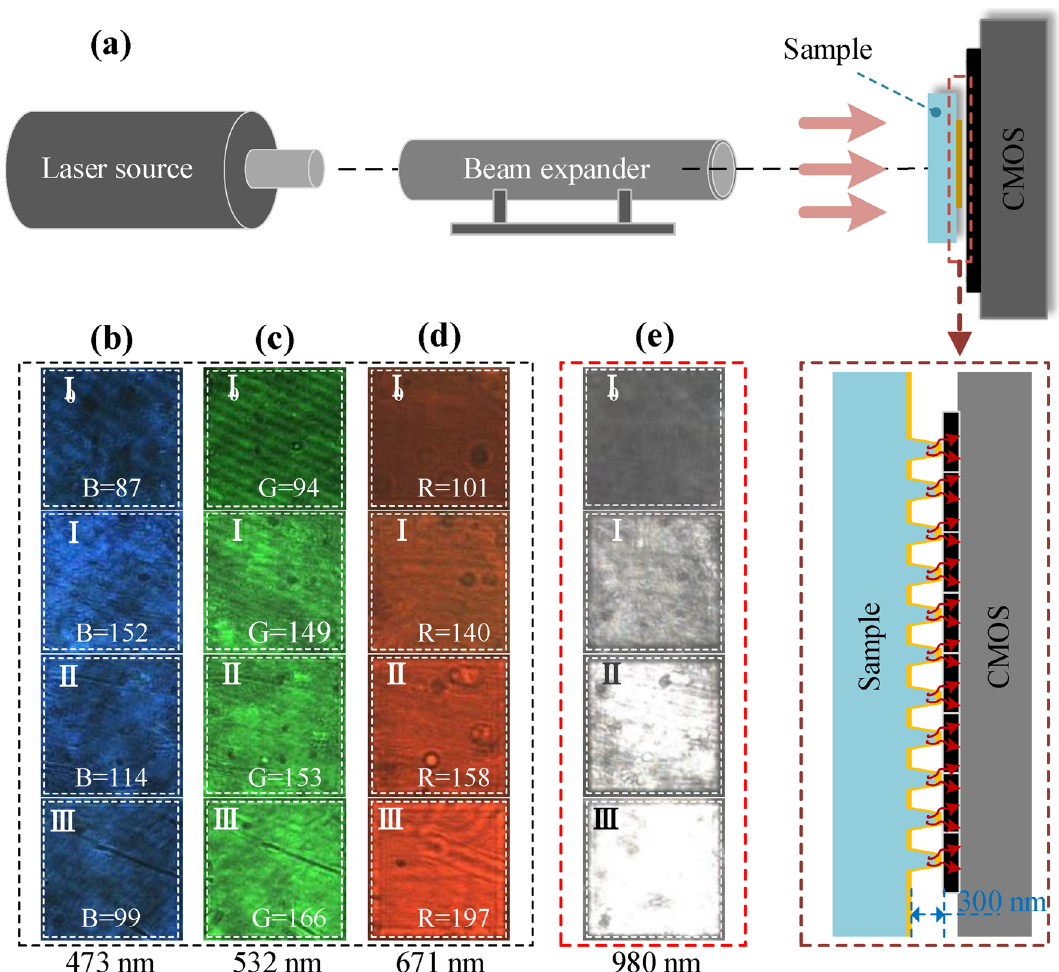
Figure 7. Detection of incident lightwaves at different wavelengths by CMOS sensors already coupled with three types of GGNCTs developed. ( a ) The coupling schematic diagram of the GGNCTs and an arrayed CMOS sensor. ( b ) to ( e ) The typical images detected at different light wavelengths including 473 nm, 532 nm, 671 nm, and 980 nm. The labels of I 0 and I to III indicate the images detected by the detector coupled to the different functional structures including the unstructured sample, the functional GGNCT-I, the GGNCT-II, and the GGNCT-III. The graphic brightness represents the strength of the imaging signal. To quantify the brightness, the pixel mean values of the R, G, and B channels are taken for the red, green and blue images respectively, and the corresponding values are inserted in each the E -field profiles of GGNCT-III at typical wavelengths of 473 nm, 532 nm, 671 nm, and 980 nm. The values of LFEF at several typical wavelengths are10.2, 225, 1024, and 7225, and the values of absorptivity A are 0.47, 0.37, 0.27, and 0.8, respectively. It can be seen that at typical wavelengths of 532 nm and 671 nm, the convergence effect appears at the top and bottom of GGNCT-III, where the LFEF are relatively large. While at 980 nm, the E -field all converges at the top of GGNCT-III forming a pair of very strong dipoles, and the LFEF reaches a high value of 7225. In summary, the near-field convergence effect is gradually significant with the increase of LFEF, and converges at the top when LFEF and A reach the maximum at the same time. At the wavelength of 473 nm, the LFEF of the three kinds of GGNCTs is at a very low value. However, the absorptivity of GGNCT-I is the highest, followed by GGNCT-II and GGNCT-III. High absorptivity will lead to a relatively strong local field on the sidewall of the nano-cone-tip, which is the reason why the detector coupled to GGNCT-I detects the strongest signal. At the wavelength of 532 nm, the LFEF of GGNCT-III is relatively larger than that of GGNCT-I and GGNCT-II, and there is a relatively large near-field convergence effect at the top and bottom of the cone, which leads to the strongest detection signal. At the wavelength of 671 nm and 980 nm, the value of LFEF increases according to a sequence of the -I to -II to -III. GGNCT-III obtains high values of 1024 and 7225 respectively, and the field enhancement effect is significant. Especially at 980 nm, the LFEF and the absorptivity A of GGNCT-III reach the maximum at the same time, and the E -field is strongly localized at the top of the nano-cone-tip. The strong local near-field will be directly received by the photosensitive element of the CMOS, forming a relatively strong detection signal. Considering the case with greater sharpness and the smaller transverse dimension of a single nano-cone-tip in the GGNCT-III, the net charges can be effectively squeezed